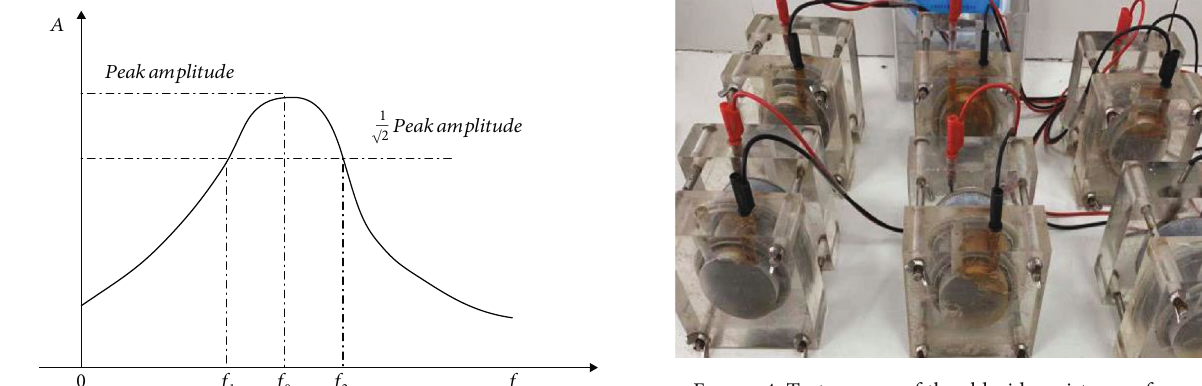
Figure 4: Test process of the chloride resistance of